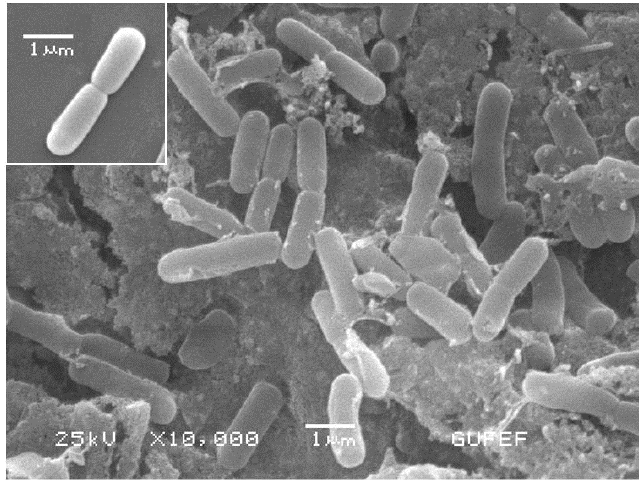
Figure 4. The scanning electron microscopy (SEM) images of E. coli immobilized with 3-MBA/1-DT modified magnetic nanoparticles on E. coli . Inset: The SEM image of unmodified E. coli